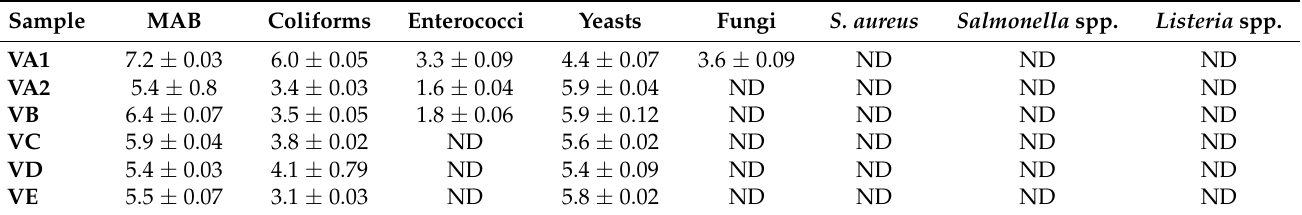
Table 3. Occurrence of monitored microbiological indicators (log CFU/mL) in vegetable smoothies. Sample Yeasts Fungi S. aureus Salmonella spp. Listeria